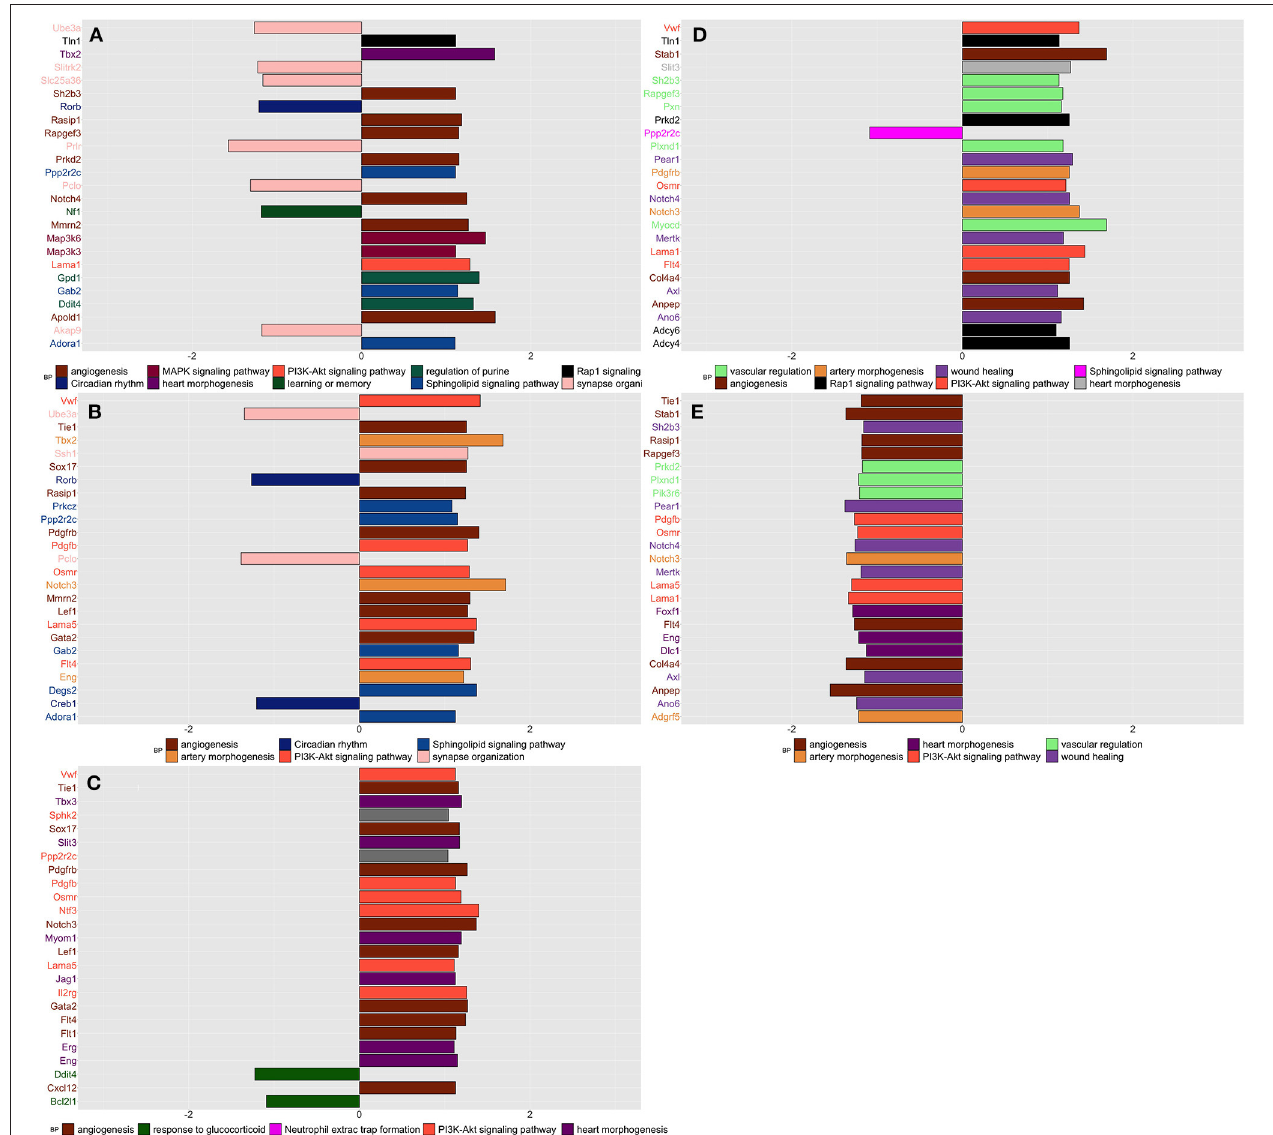
FIGURE 3 | Summarizes the results of both gene-set and gene differentially expressed (DE) in spinal tissue across conditions and time. We focused on the top DE gene-sets and top 25 most significant DEGs that were enriched mostly in inflammatory and neurological pathways. (A) SIH vs. Naïve at week 1, (B) CPH vs. Naïve